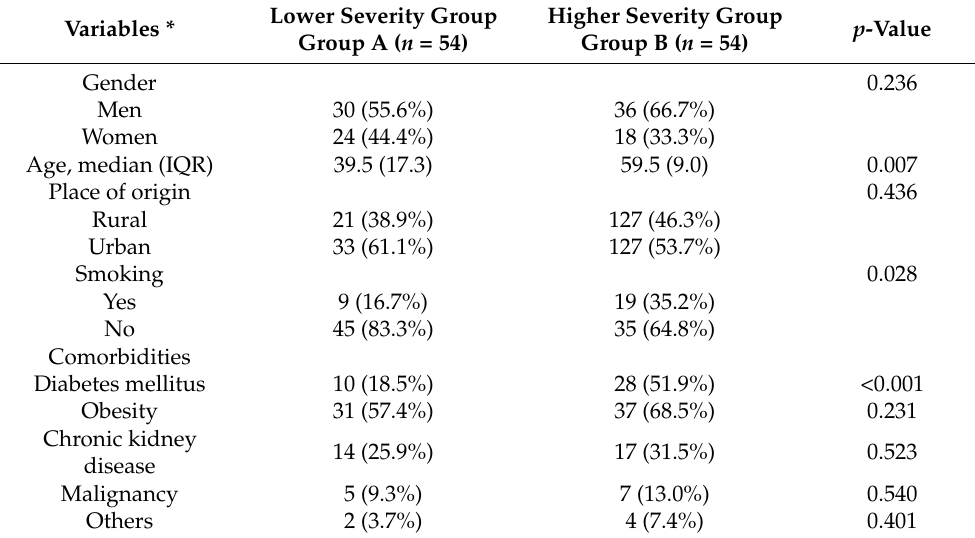
Table 2. Comparison of background characteristics among patients with odontogenic infections.